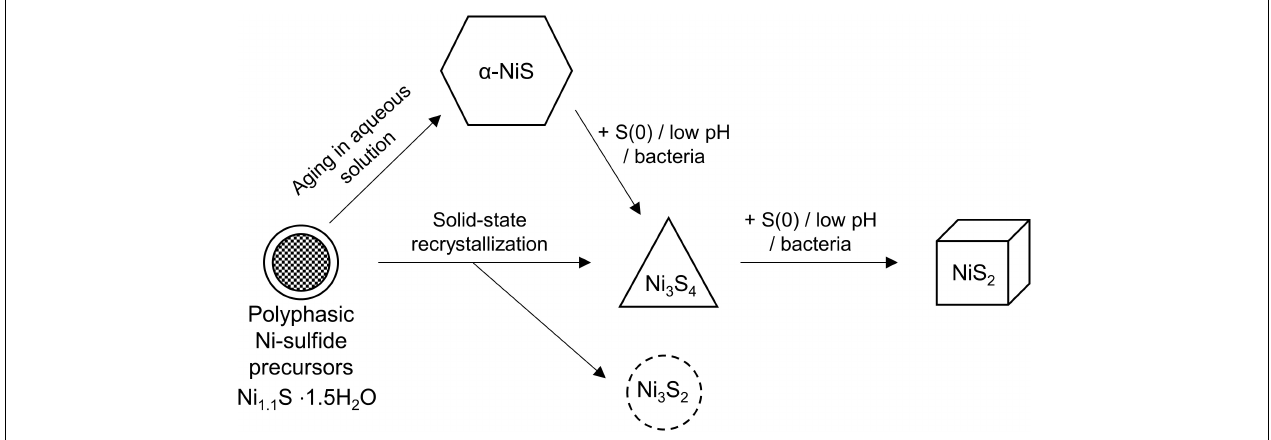
FIGURE 9 | Diagram depicting the crystallization sequence of Ni-sulfides. The initial precipitate is polyphasic Ni-sulfide precursors. Metastable α -NiS can form naturally within a few hours to days. In the presence of S(0) or bacteria or acidic pH, α -NiS recrystallizes to form polydymite (Ni 3 S 4 ) and vaesite (NiS 2 ). Polydymite and heazlewoodite (Ni 3 S 2 ) can also form through solid-state recrystallization of hydrated NiS under an anoxic atmosphere.